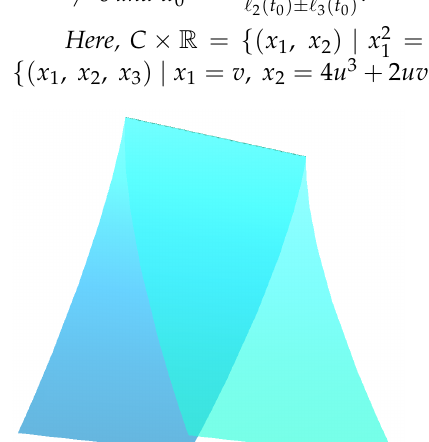
Figure 1. Cuspidal edge.